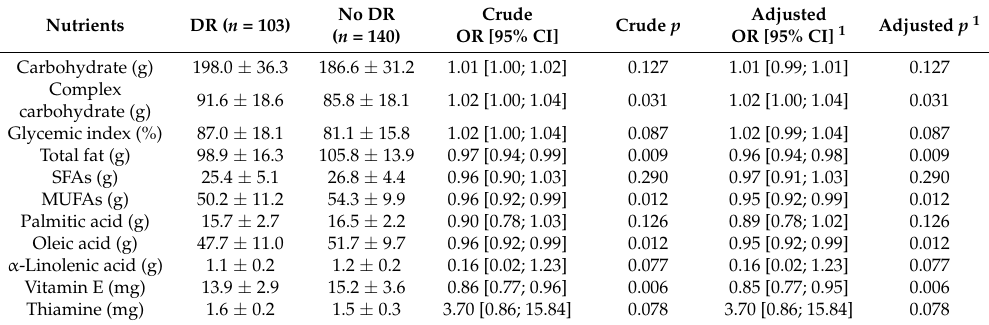
Table 4. Crude and adjusted multivariate analysis for the presence of diabetic retinopathy and daily nutrient